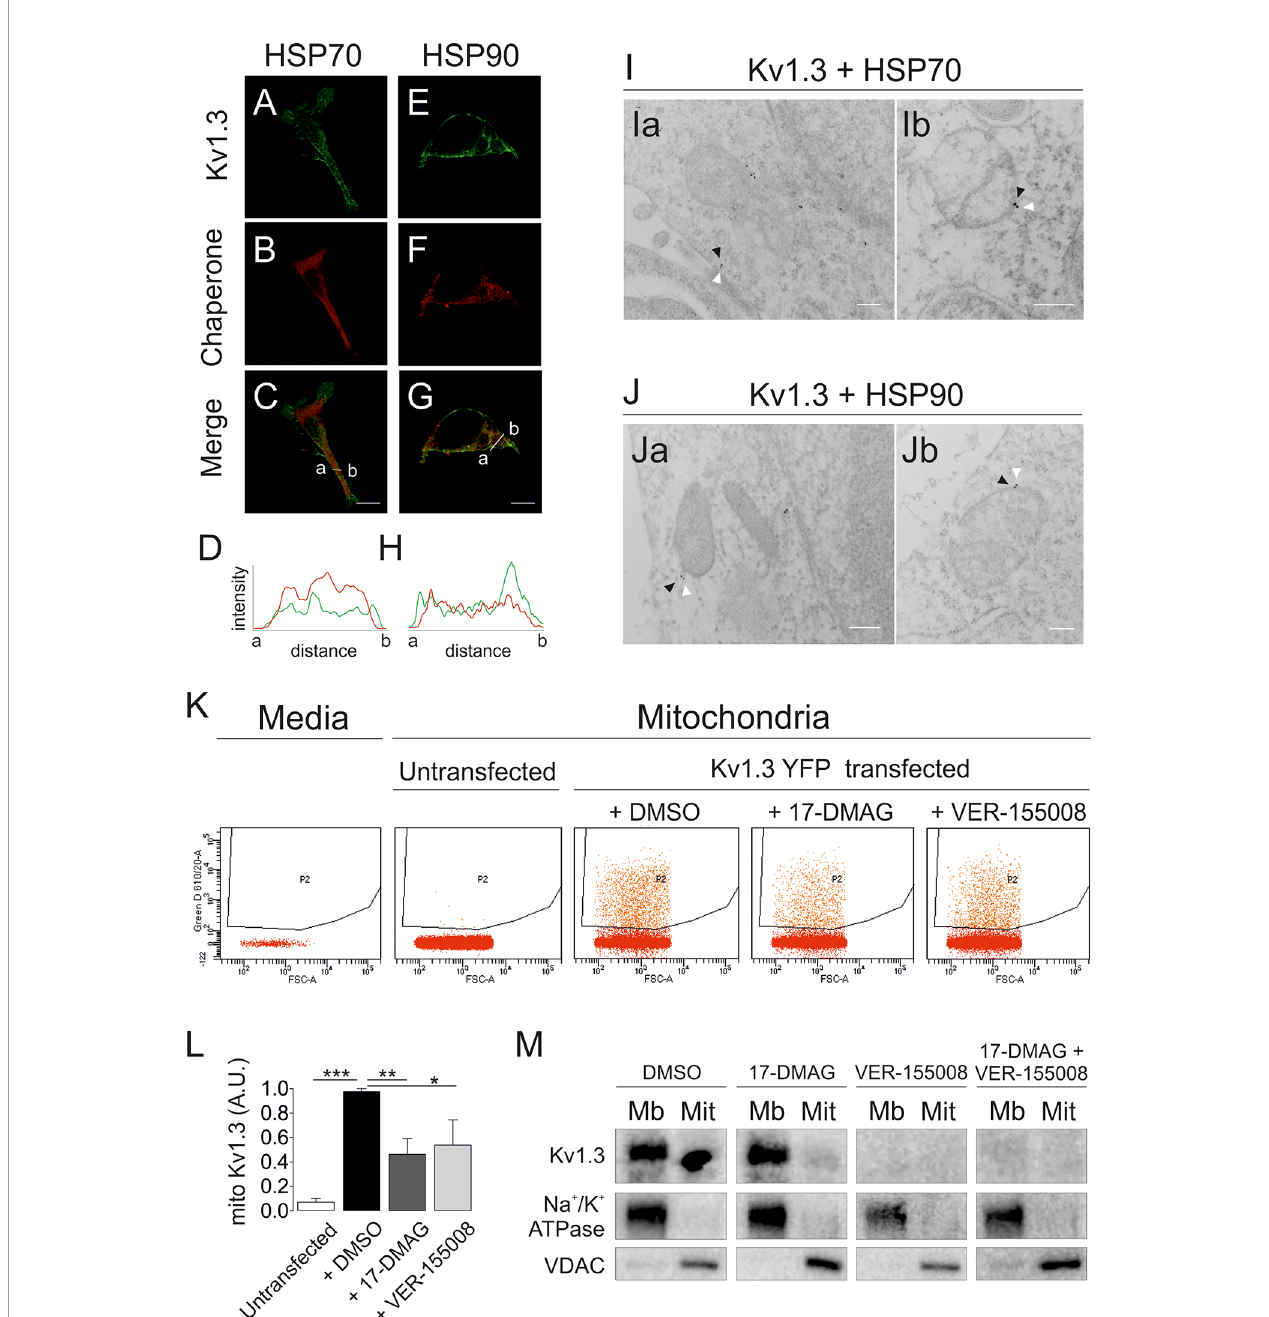
FIGURE 3 | Cytosolic HSP70 and HSP90 chaperones assist with Kv1.3 mitochondrial import. HEK 293 cells were transfected with Kv1.3YFP and subsequently stained with antibodies against HSP70 and HSP90. (A – G) Representative confocal images showing colocalization between Kv1.3YFP (green) (A, E) and HSP70 (B) or HSP90 (F) (red). (C, G) The merged image shows colocalization in yellow. (D, H) Histogram showing the pixel-by-pixel analysis of the section indicated by the line in the merged Panels (C, G) . (I, J) Electron micrographs of HEK 293 cells transfected with Kv1.3YFP. Immunogold particles with sizes of 12 and 18 nm show chaperones (white arrowheads) and Kv1.3 (black arrowheads), respectively. (I) HSP70; (J) HSP90. Scale bars represent 200 nm. (K) HEK 293 cells transfected with Kv1.3YFP were treated with DMSO (vehicle), 20 m M VER-155008 (HSP70 inhibitor) or 1 m M 17-DMAG (HSP90 inhibitor) for 18 h Next, mitochondria were puri fi ed, and the YFP intensity was analyzed using fl ow cytometry. Media (DMEM) and untransfected mitochondria were used as negative controls. (L) Quanti fi cation of relative mitochondrial Kv1.3YFP expression upon the indicated treatments. Data are presented as the means ± SE of 3 independent experiments. *p < 0.05, **p < 0.01, and ***p < 0.001 (Student ’ s t test). (M) Immunoblot of plasma membrane (Mb) and mitochondrial (Mit) fractions of HEK 293 cells transfected with Kv1.3YFP and treated with chaperone inhibitors. Membranes were immunoblotted with antibodies against Kv1.3 (top panels), Na + /K + ATPase (center panels) and VDAC (bottom